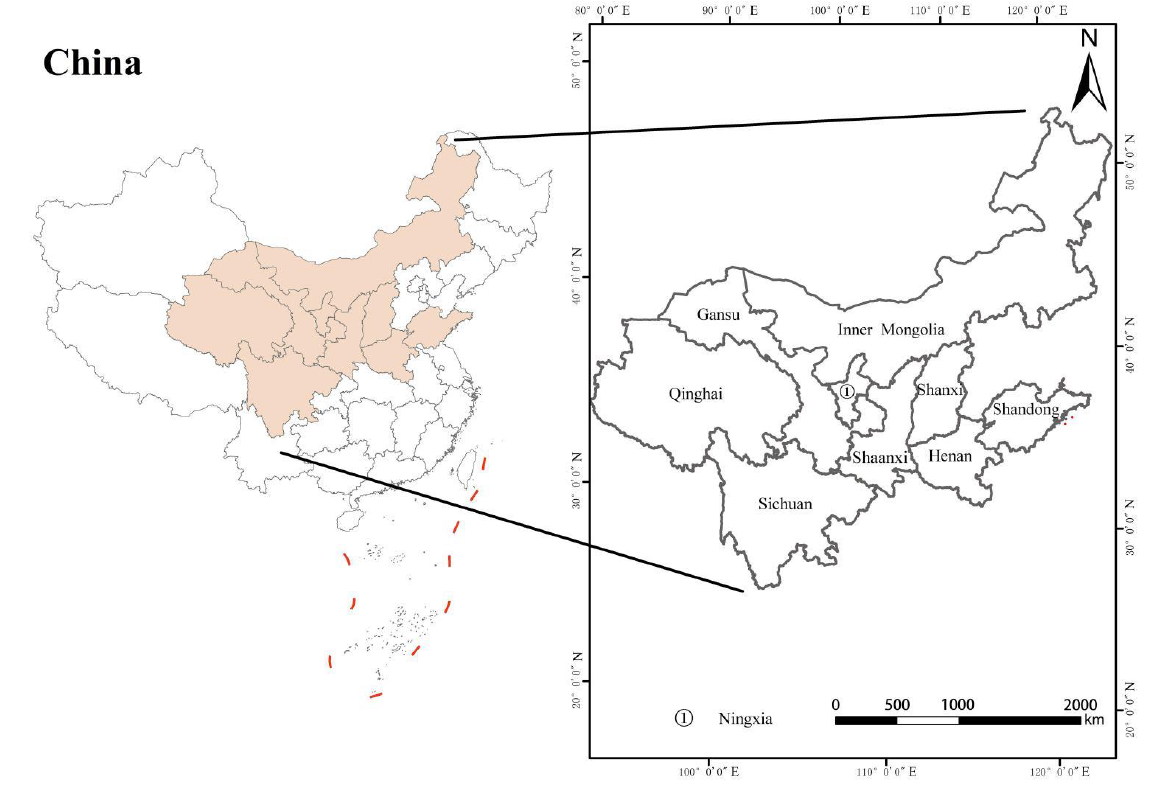
Figure 2. Research area of nine provinces in the Yellow River basin, China. Table 1. Dataset source information.